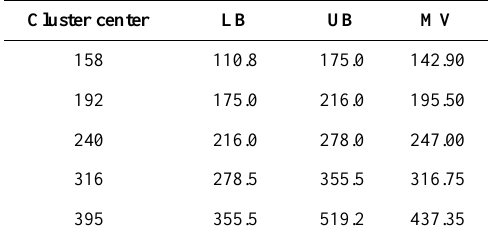
Table 11. Calculation of lower bound (LB), upper bound (UB), and middle value